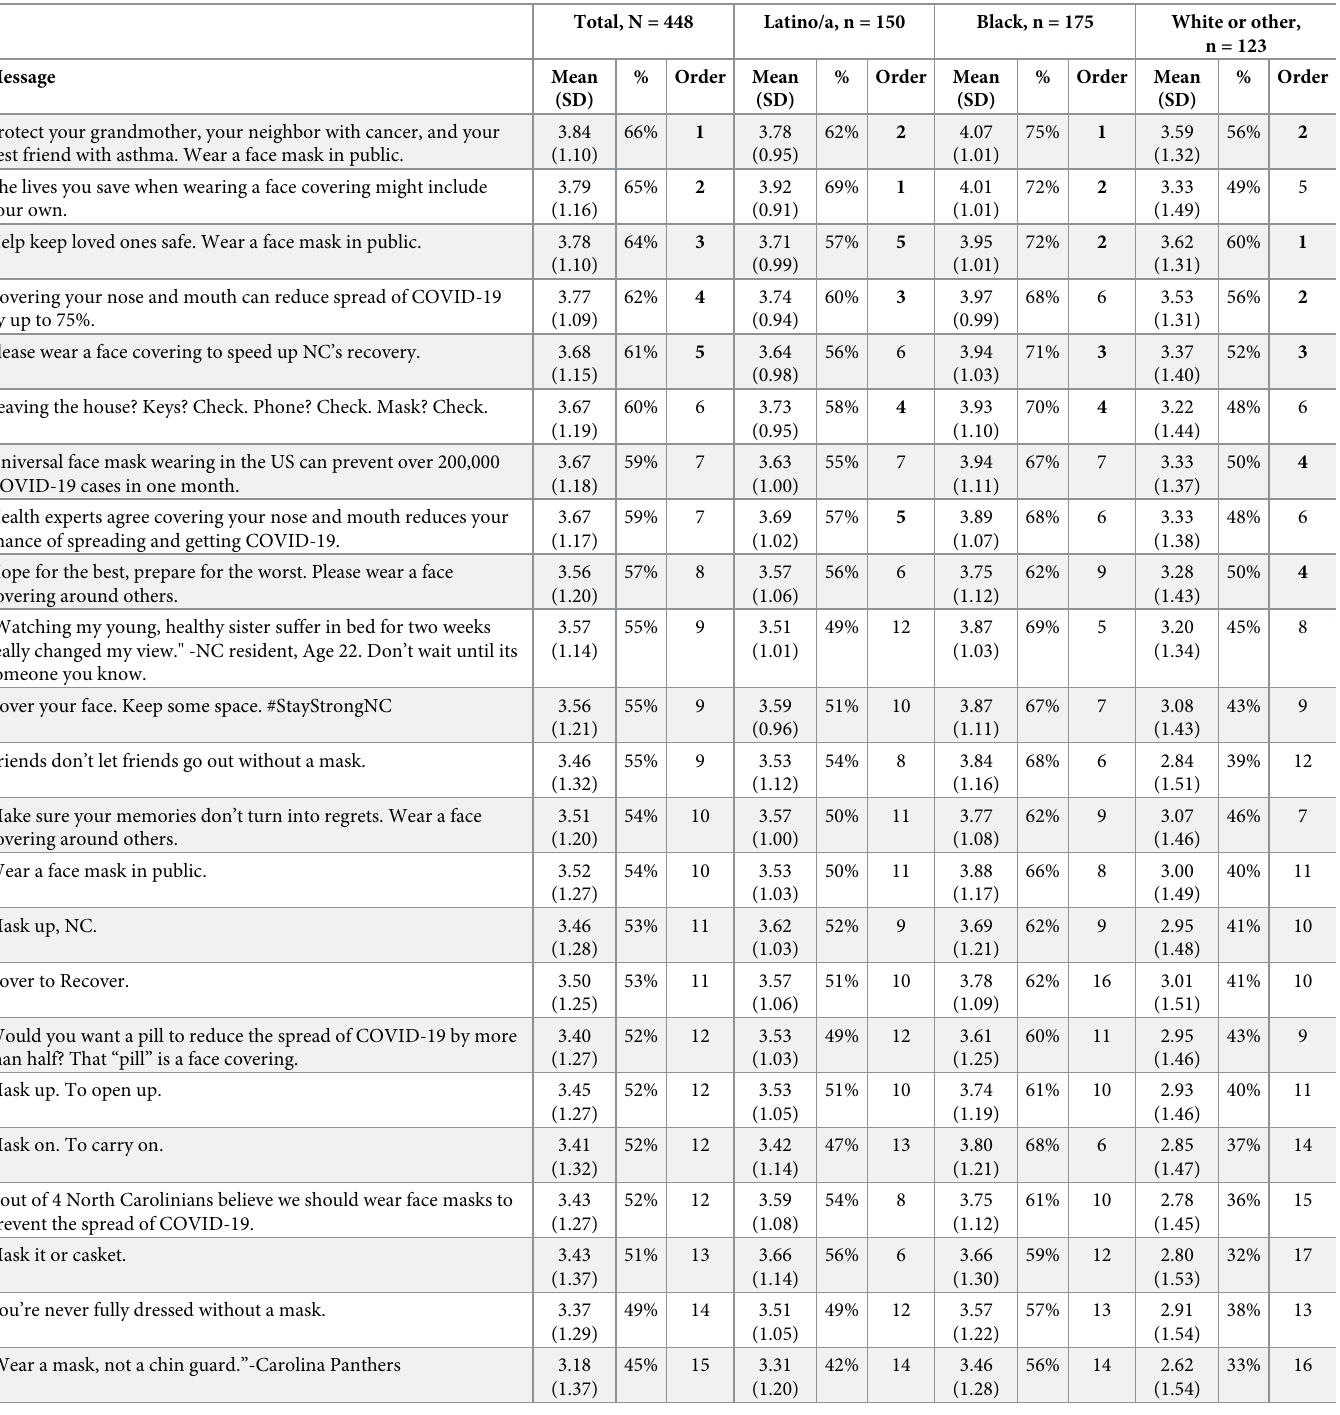
Table 4. Messages encouraging face covering